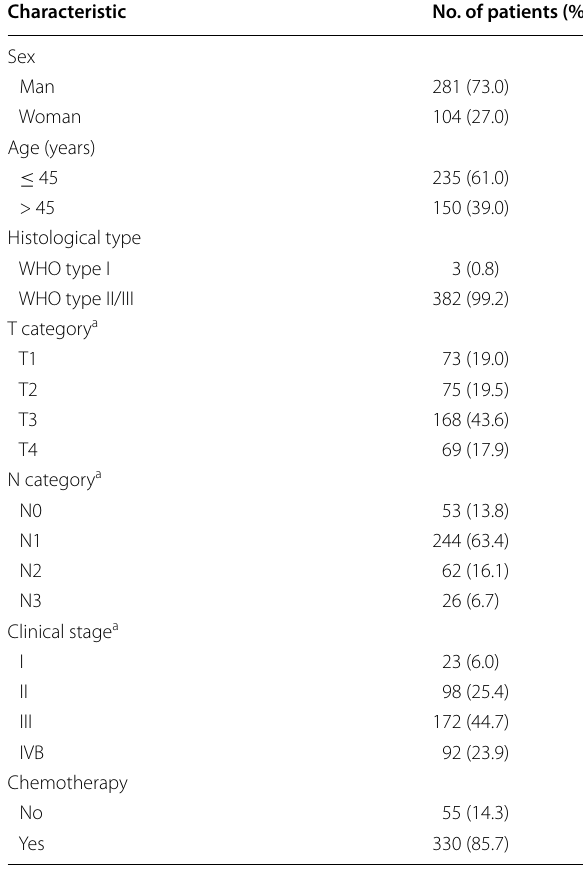
Table 1 Clinical characteristics of the 385 patients with nasopharyngeal carcinoma (NPC) who were treated with intensity-modulated radiotherapy